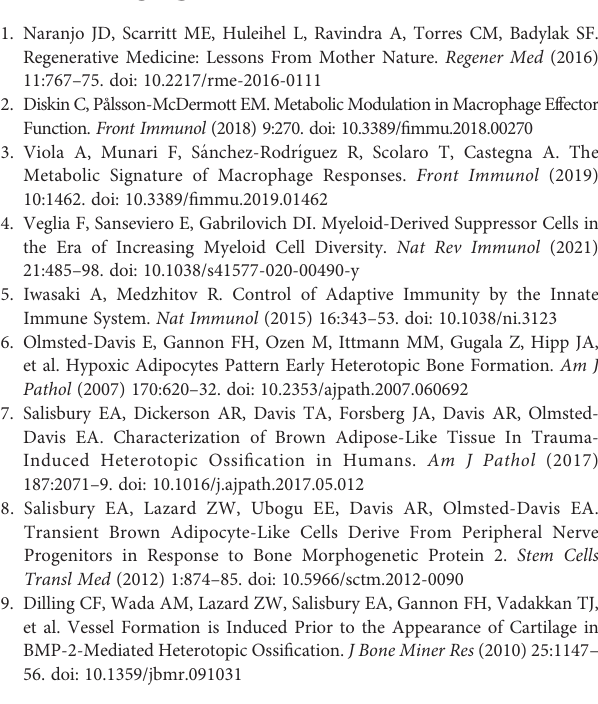
Supplementary Table 1 | Top 50 transcripts in each cluster MH0 to MH7 and FC0 to FC10. The top 50 transcripts are listed for each cluster. Supplementary Table 2 | Macrophage markers (MH0-MH6) in FC5. The transcripts from FC5 were compared to the top 50 transcripts of each cluster MH0 to MH7. A plus sign indicates the presence of a corresponding transcript in FC5, while a minus sign indicates the absence of a corresponding FC5